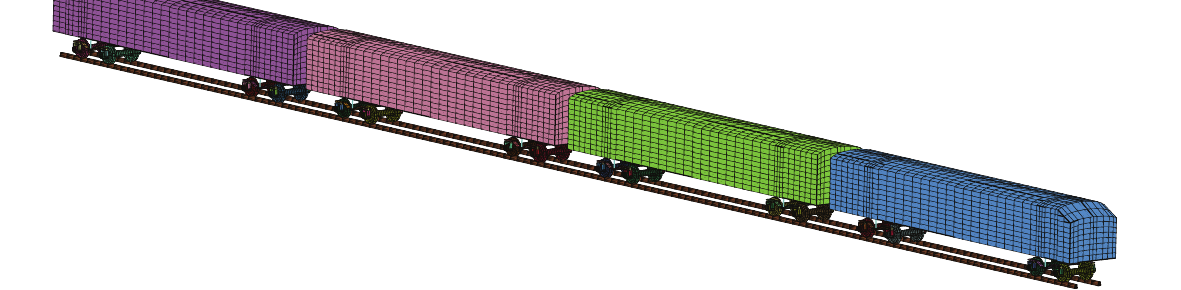
Figure 3: Finite element model of the train.